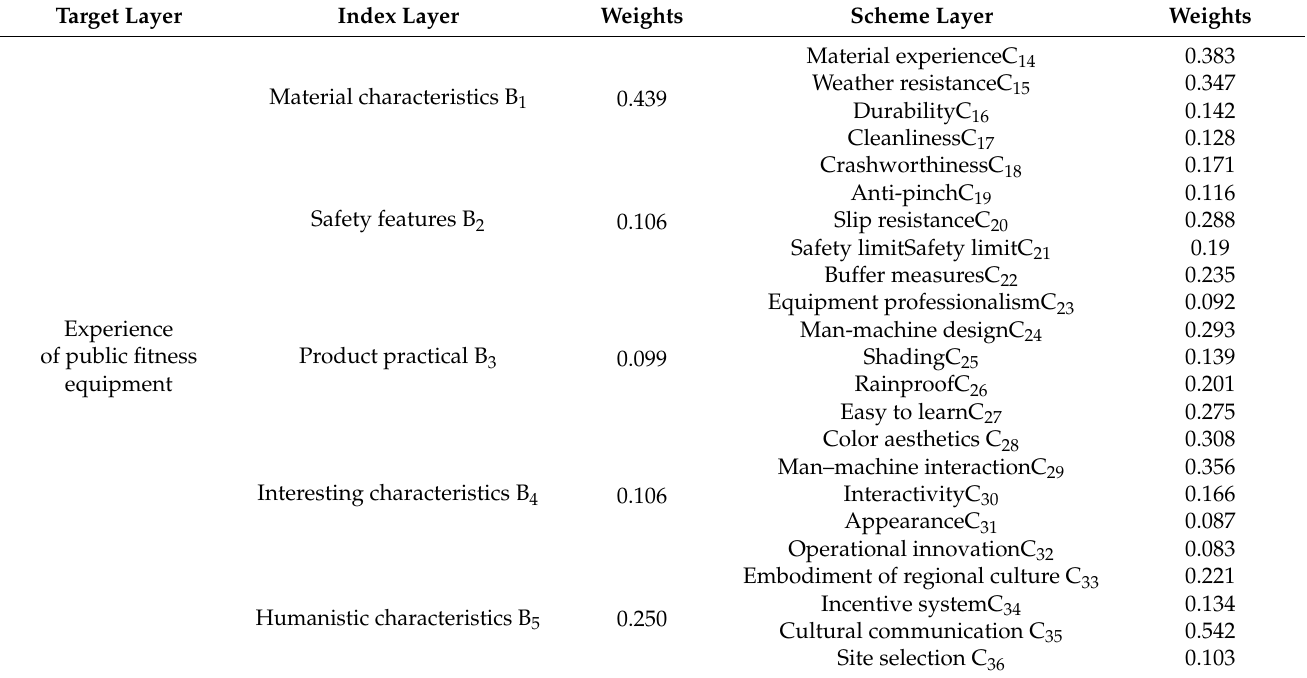
Table 4. Weights of public fitness equipment experience evaluation index